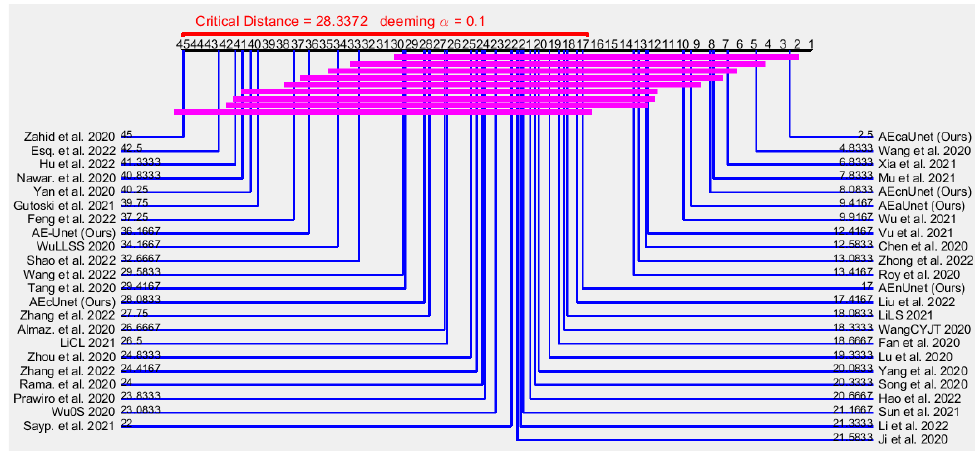
Figure 19. Nemenyi [141] post hoc critical distance diagram for α = 0.10 using fAUC numerics in Table 8 for G 3